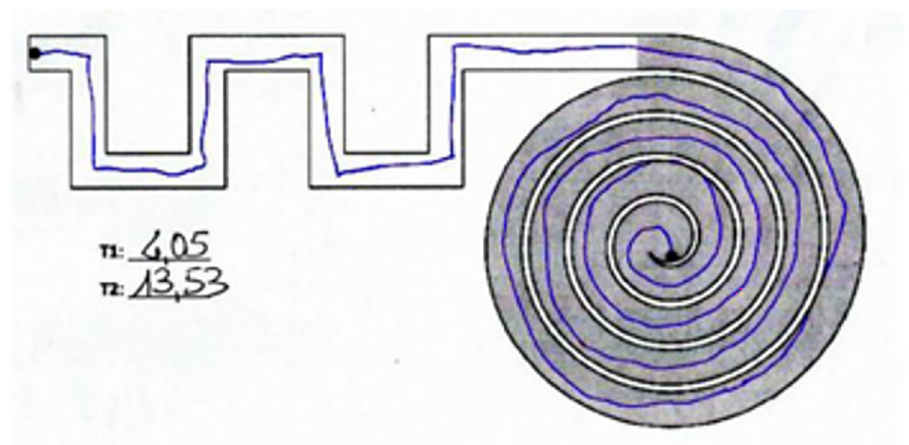
Fig 4. Recognized line colored in blue after the proper thresholding passages. Test taken by a healthy control.